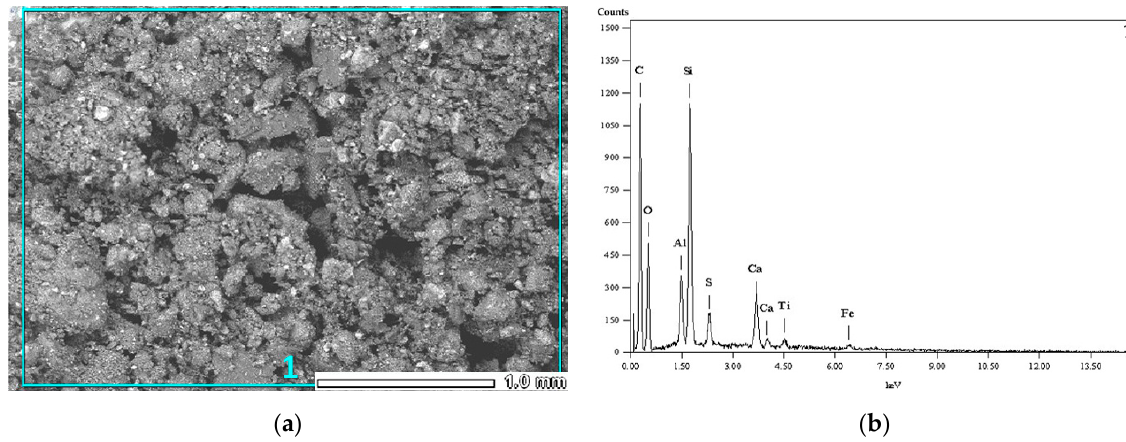
Figure 2. Dispersion energy spectrum of X-rays (EDS) for certain area (1) of brown coal, ( a ) photo of analyzed sample of brown coal; ( b ) spectrum.